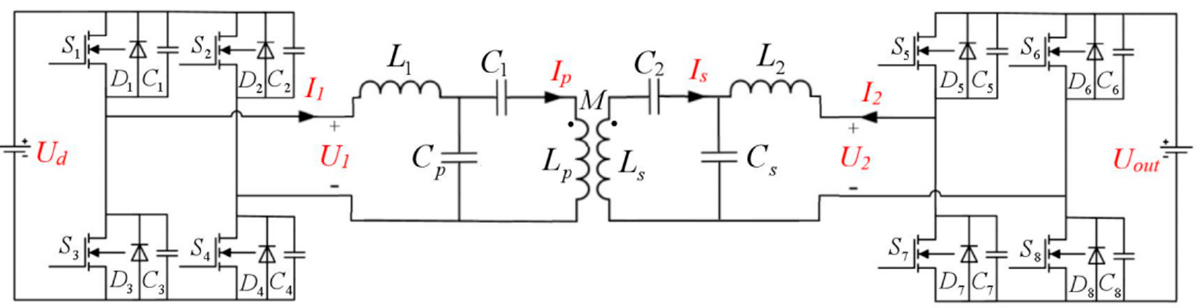
Figure 2. Dual-LCC compensation and the circuit of WPT system.